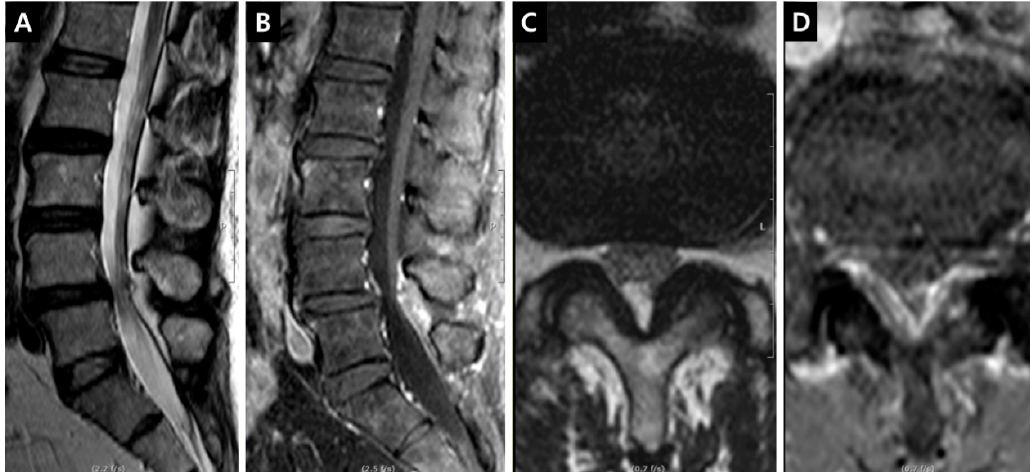
Figure 3. Enhancement patterns: dorsal epidural vein (DVCE). ( A ) T2-weighted midsagittal image; ( B ) Fat-suppressed enhanced T1-weighted midsagittal image showing the prominent enhancement on the dorsal dural surface; ( C ) T2-weighted axial image on the L4-5 disc level; ( D ) Fat-suppressed enhanced T1-weighted axial image on the L4-5 disc level, the definite enhancement on the ventral surface of ligamentum flavum in the dorsal epidural space can be seen.